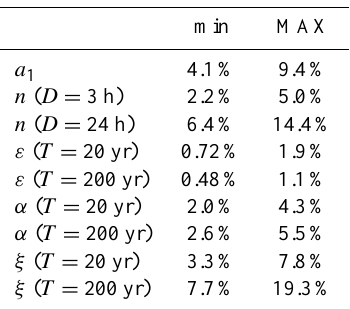
Table 3. Relative partial uncertainty component (%) on h T,D with respect to each estimated parameter, minimum and maximum value among all